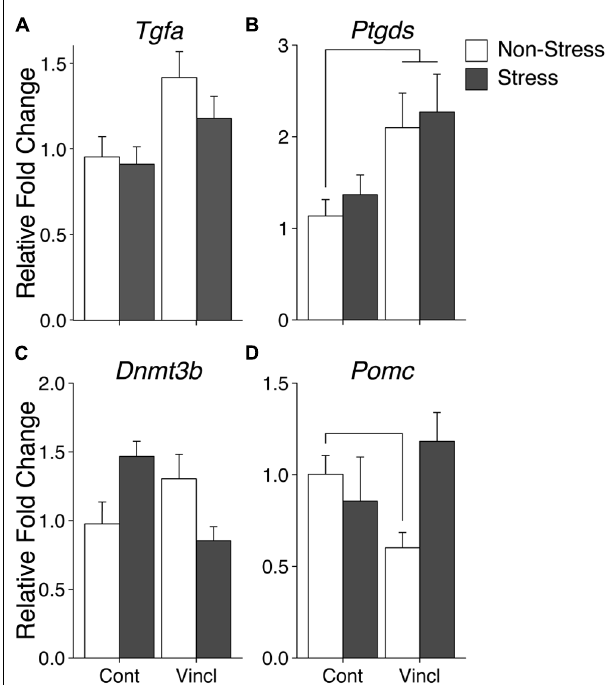
FIGURE 2 | Gene expression in the central amygdala. Relative gene expression of Growth factors Tgfa and Ptgds (A,B) show effects of vinclozolin treatment, both up-regulated by ancestral vinclozolin treatment. (C) Epigenetic modification enzyme Dnmt3b shows an interaction with C-S andV-NS up-regulated andV-S near baseline. (D) Stress signaling propeptide Pomc shows a significant interaction with C-S andV-NS animals slightly down-regulated. Lines connecting group bars signify a significant post hoc pair-wise